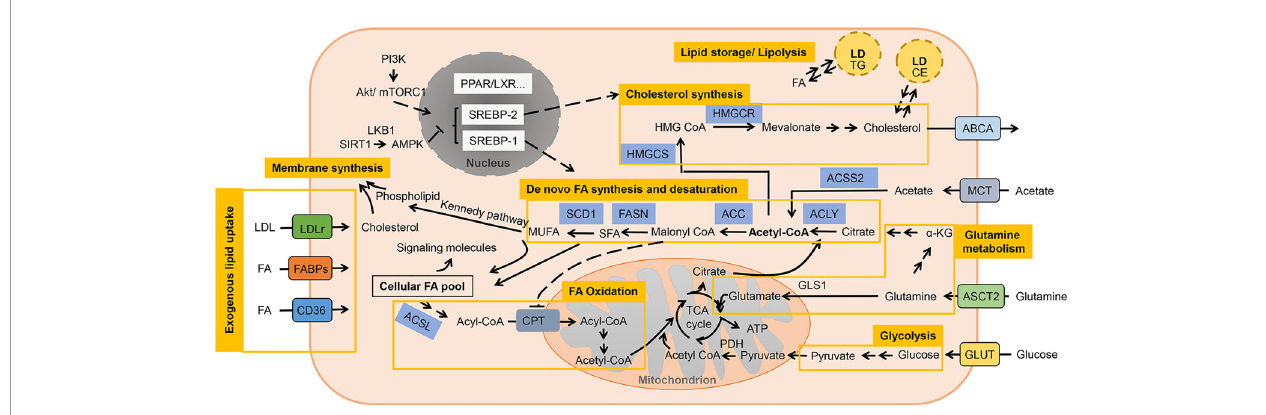
FIGURE 1 | A brief representation of altered lipid metabolism in cancer cells. Lipids are metabolized in cancer cells involving molecular process of uptake, de novo synthesis, degradation, storage and lipolysis. Aside from being structural components of membrane, lipids also function as energy sources and signaling factors coordinating various biological processes. Acetyl-CoA is the main substrate for lipid synthesis while the altered metabolism of glucose, glutamine and acetate could contribute to this metabolic pathway by providing precursors. FAs are then either break down through mitochondrial b -oxidation to produce energy, or utilized in membrane synthesis together with cholesterol. Excessive lipids are then usually stored in LDs as TG and CE, and could be mobilized for another source of lipids. LD is recognized as important cellular organelle in regulating autophagy and anti-lipotoxicity. SREBPs are pivotal transcription factors that respectively modulates the genes involved in the uptake and synthesis of fatty acid and cholesterol, and responds to the upstream signaling (i.e., PI3K/AKT/mTOR, AMPK pathway). Other pathway like PPAR and LXR signaling also play an active role in modulating lipid